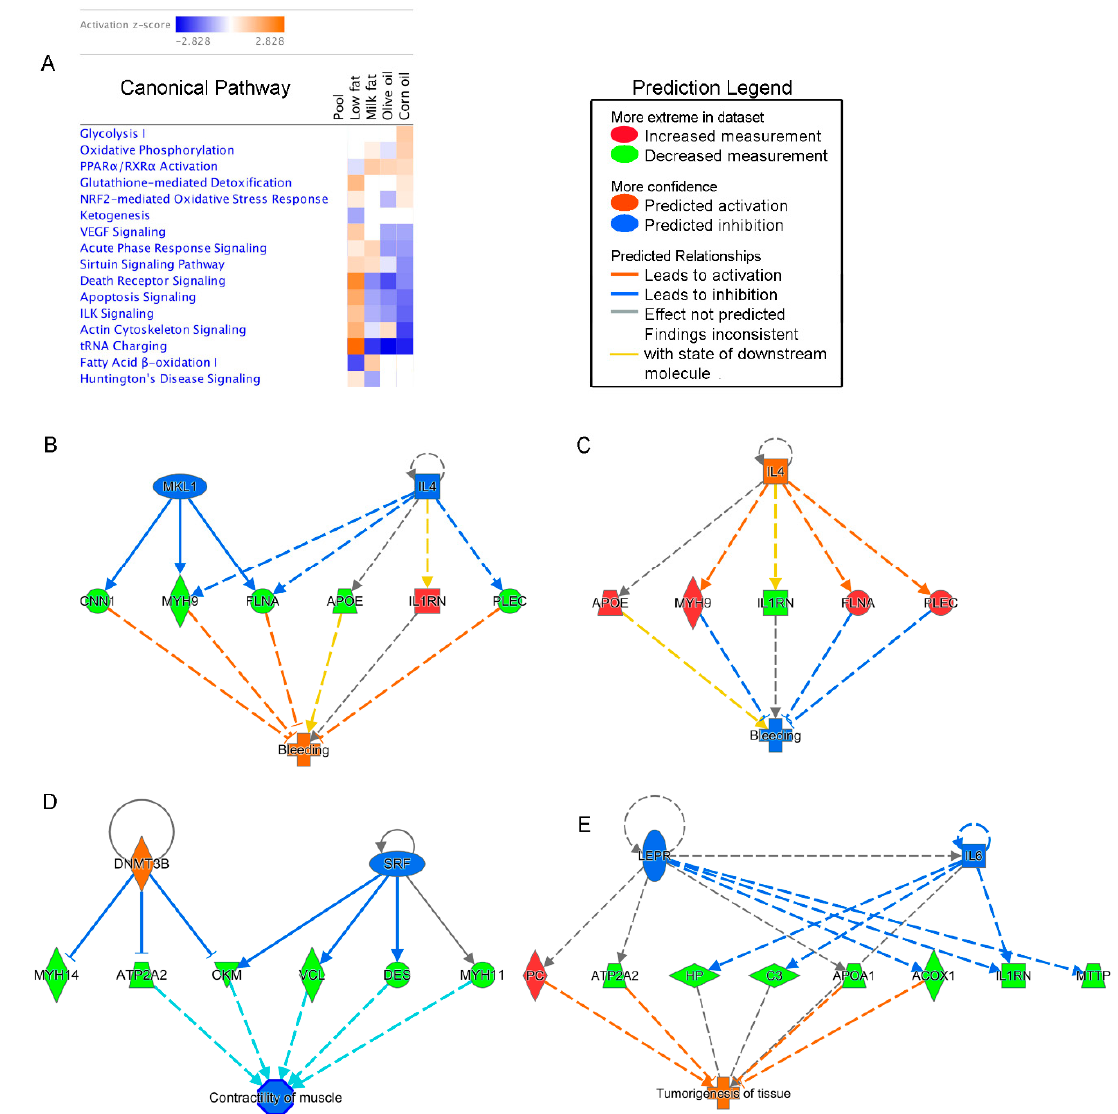
Figure 5. Effects of lipid diets on the gut proteome shown by the Ingenuity pathway comparative analysis. ( A ) Heatmap visualization of metabolites detected in each dietary group. Orange color indicates a higher activation score, whereas blue color indicates a lower activation score. Ingenuity pathway analysis (IPA) identified many upstream regulators predicted to be active based on the gene expression profile including: ( B ) bleeding in the high-fat corn oil and ( C ) low-fat chow groups, ( D ) contractility of muscles in the corn oil group and ( E ) tumorigenesis of tissue in the olive oil group. Faded colors represent less of an effect.